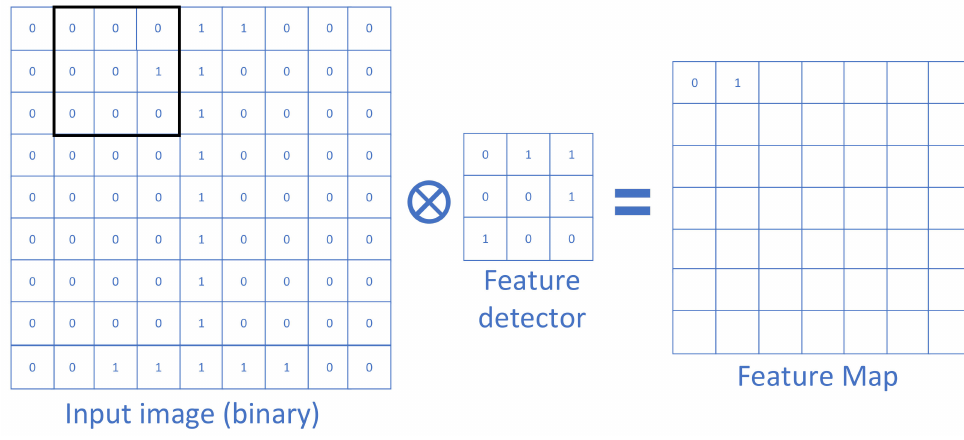
Figure 2. Binary conversion of feature map 2.